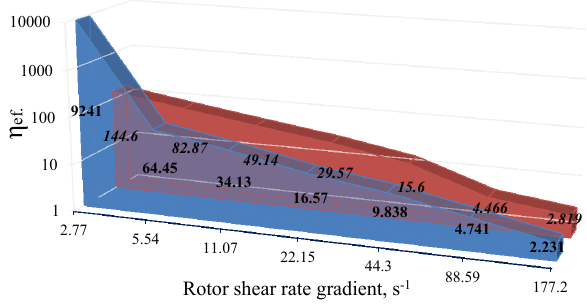
Figure 3 Rheograms for various types of dietary fibre: blue for WF 600 wheat; red for KF 500 potato